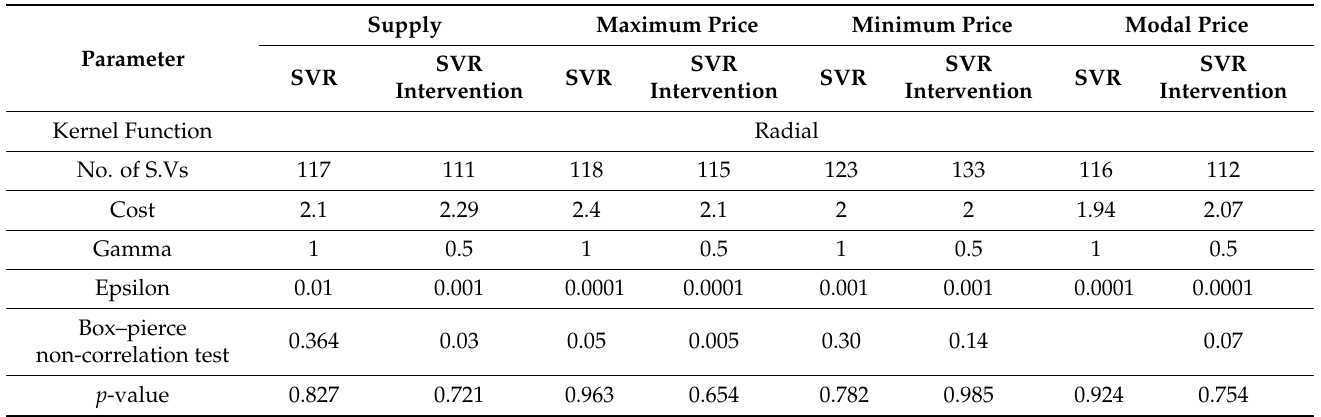
Table 5. Parameter specification of SVR and SVR intervention